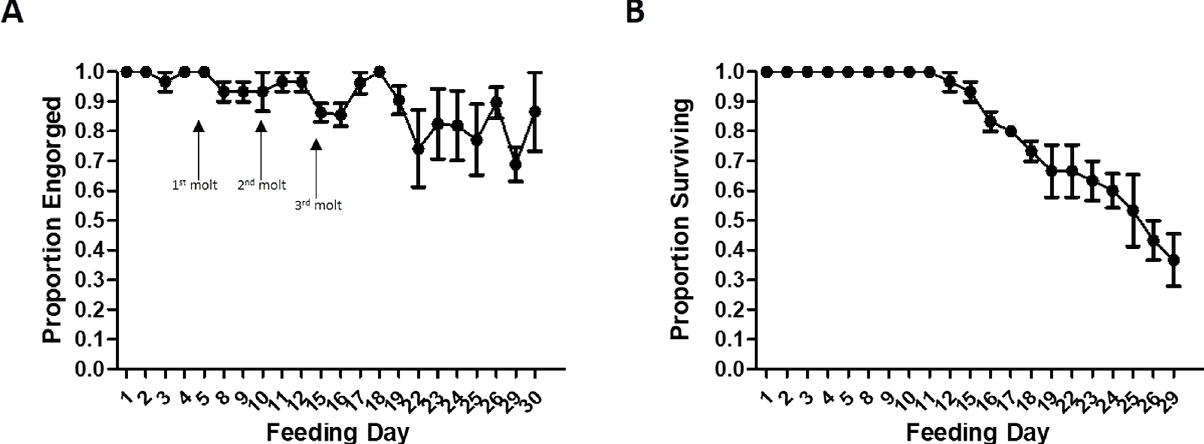
Figure 2. Feeding success and survival of lice fed on in vitro system. (A) The proportion of living lice engorging was measured after each 30 min feeding session. (B) The proportion of lice surviving each feeding session was measured on the subsequent feeding day. N = 3 biological replicates of 10 lice. Plots indicate mean ± SEM.